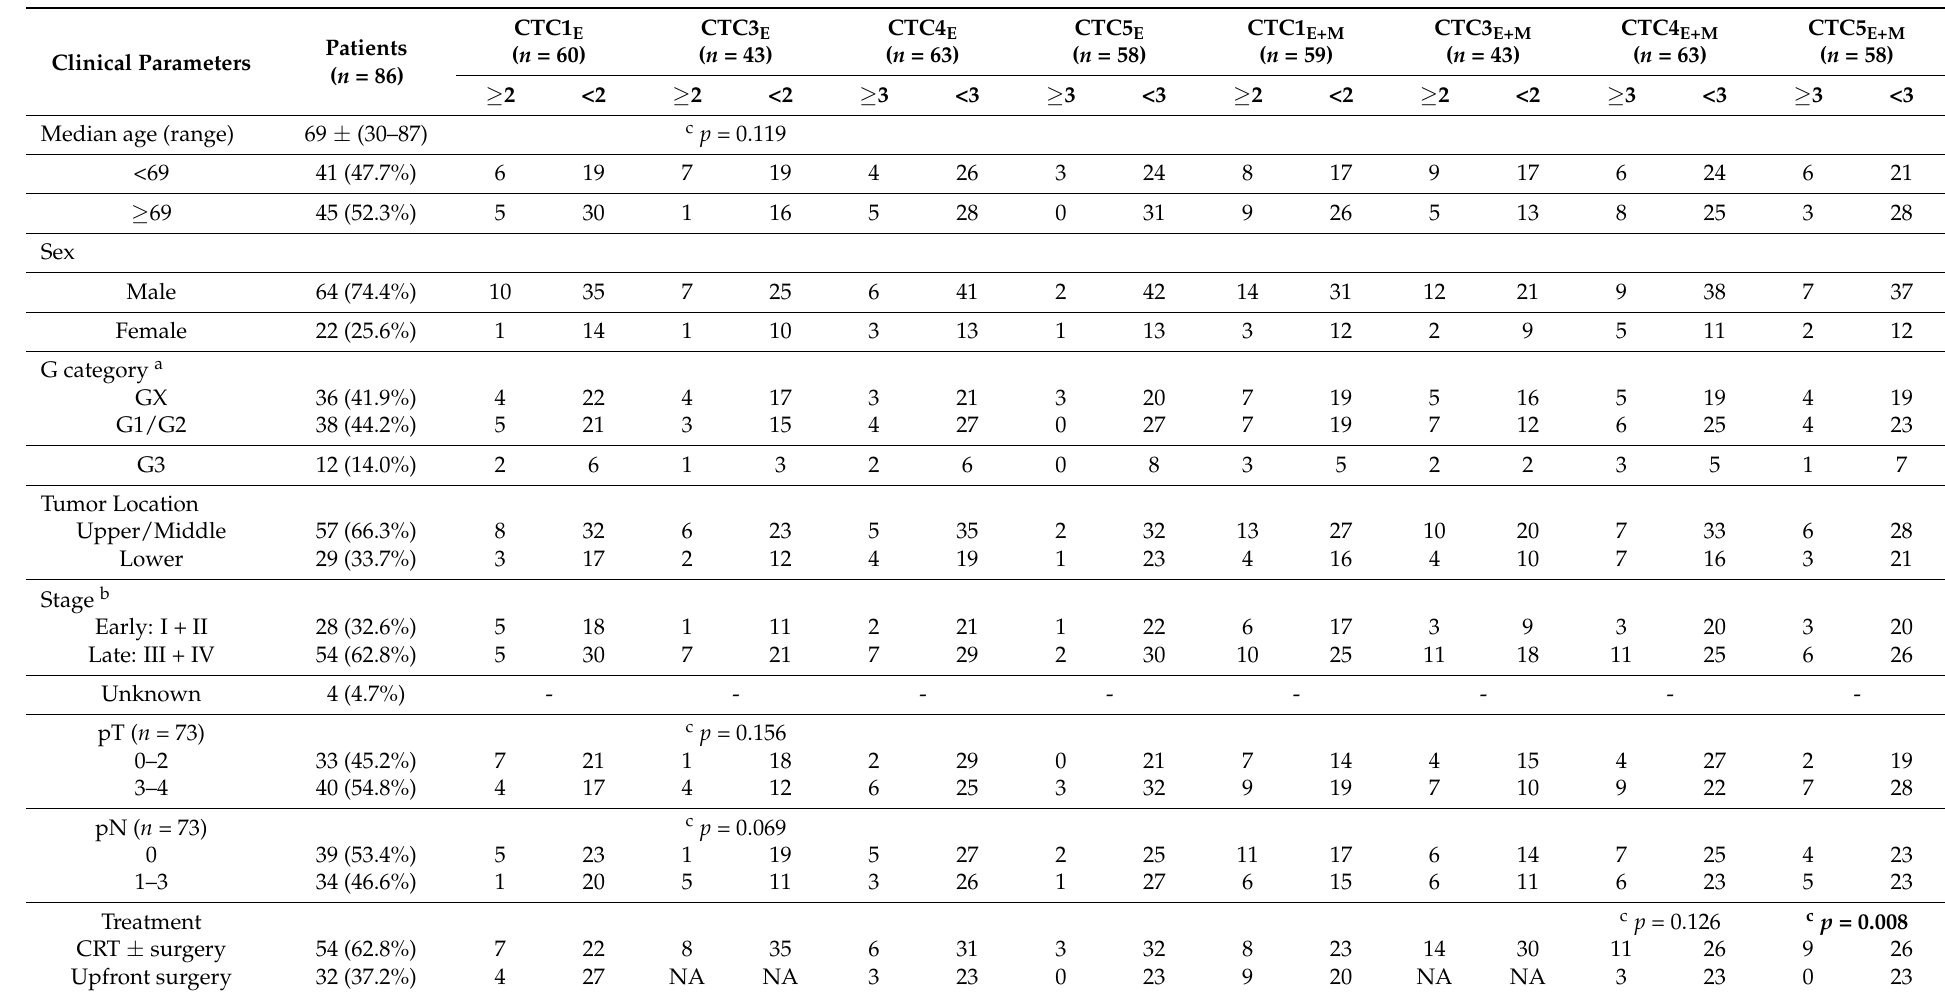
Table 1. Baseline characteristics of CTC bloods for serial monitoring of CTC counts in ESCC